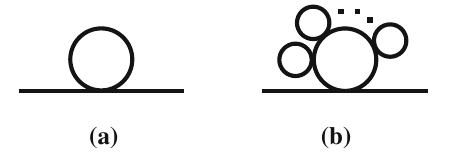
leading in T and N to the two-loop daisy, d the three-loop superdaisy contribution, which is subleading in T but of equal order in N to the three-loop